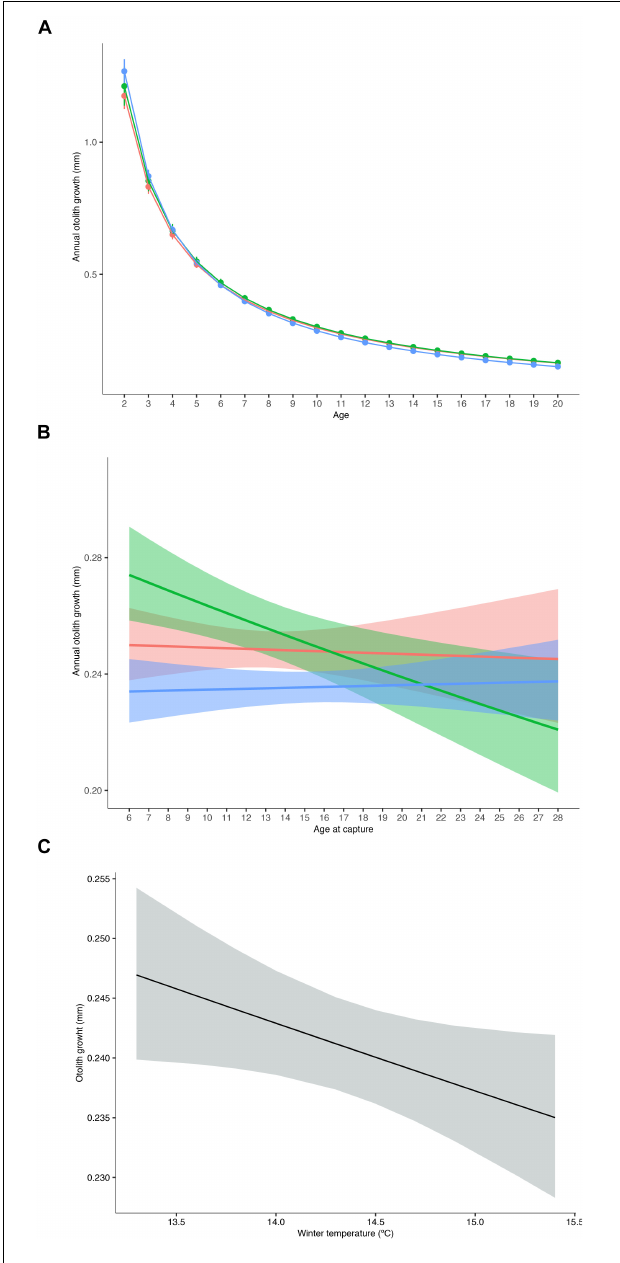
FIGURE 3 | Annual mean otolith increments from Western (blue), Central (red), and Eastern (green) island groups by (A) age and (B) Age-at-capture; and (C) overall effect of average winter temperature (January–March) at depth (98–618 m) on Pagellus bogaraveo otolith growth. Vertical lines in (A) and shaded areas in (B,C) denote ± 95% CI.